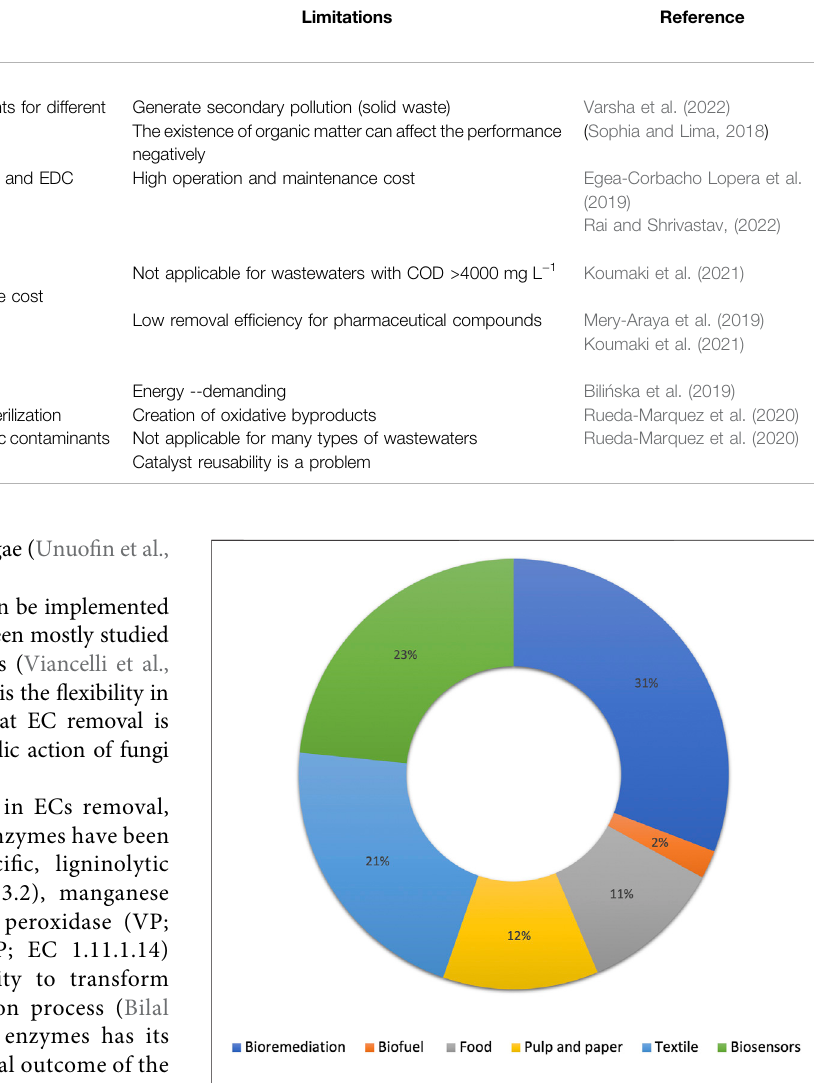
FIGURE 2 | Percentage of laccase application in different industries (adapted from Mate and Alcalde